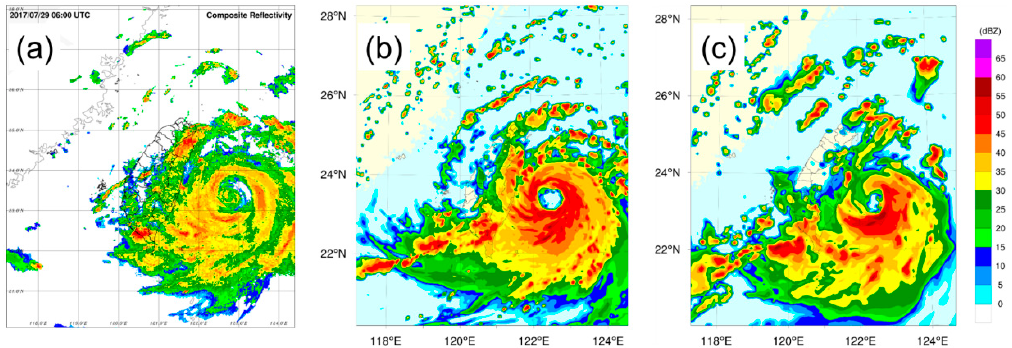
Figure 9. Radar reflectivity (dBZ) for TC Nesat at 6-h forecast (valid for 0600 UTC 29 July 2017) from ( a ) observation, ( b ) V2D2 and ( c ) V1D3.